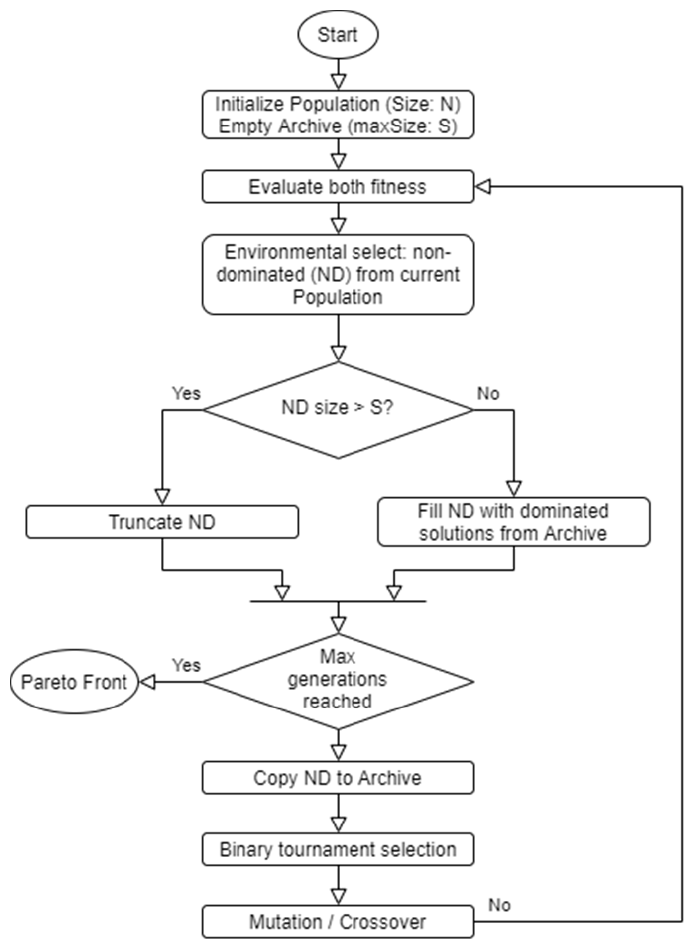
Figure 3. SPEA2 algorithm flowchart.